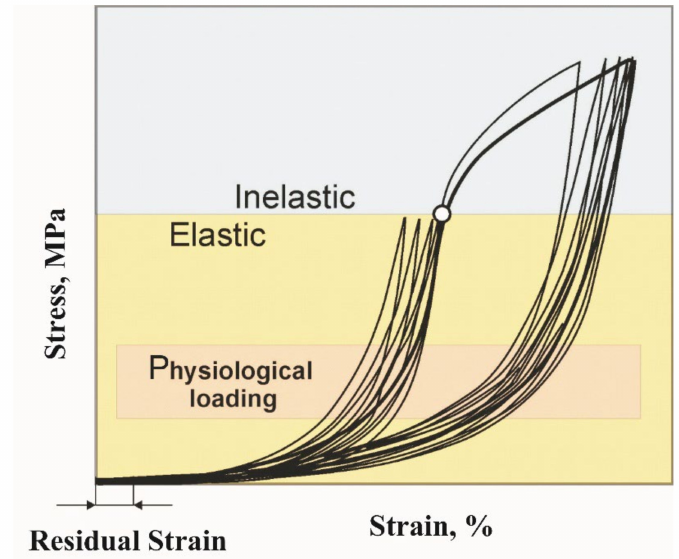
Figure 3. Generalized stress-strain curves of biological tissues showing physiological loading range.